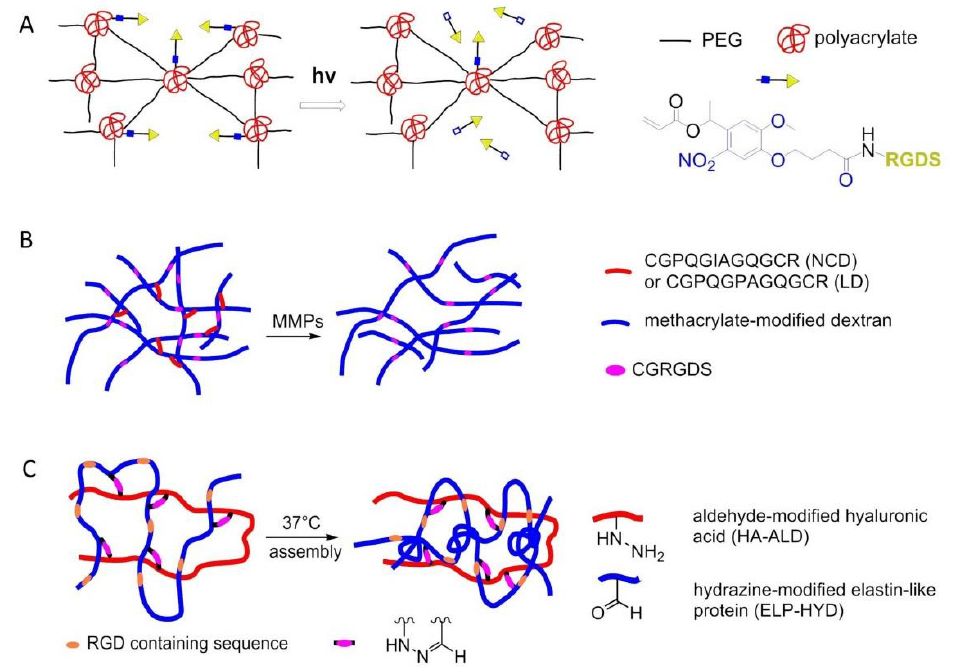
Figure 23. Smart interfaces for 3D cell culture. ( A ) Poly(acrylate)-PEG 3D gel containing RGD peptide and photocleavable domain. ( B ) ELP-HA hydrogel containing RGD sequence. ( C ) DexMA hydrogels functionalized RGD peptide.